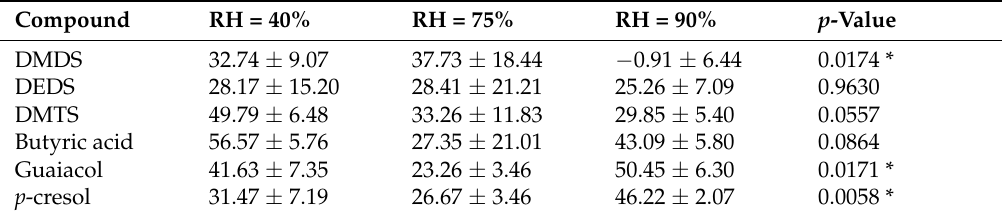
Table 5. VOC reduction rate (%) at different relative humidity (RH) levels.